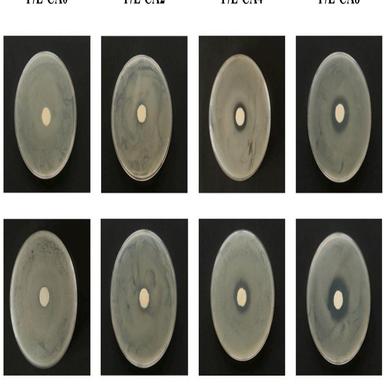
The inhibition zones of P/E-CA composite nanofiber films against E. coli and S. aureus.